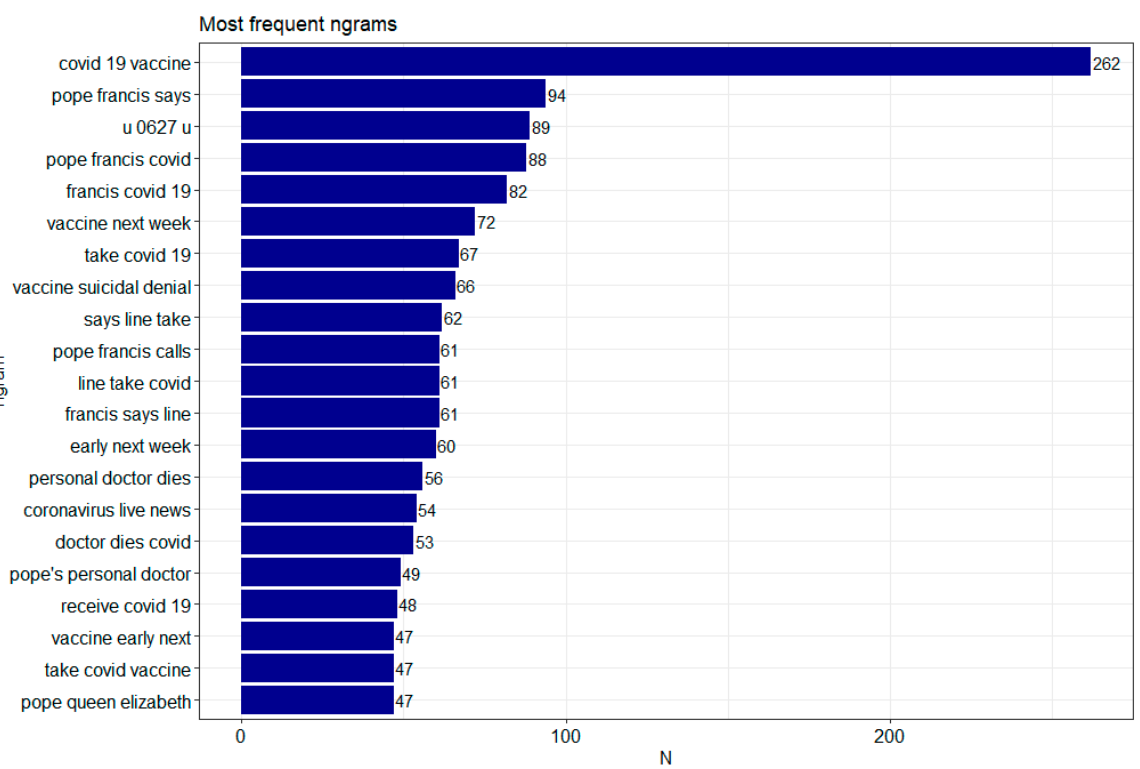
Figure 5. The most common trigrams. Made using ggplot2, tm and tidytext libraries in R.